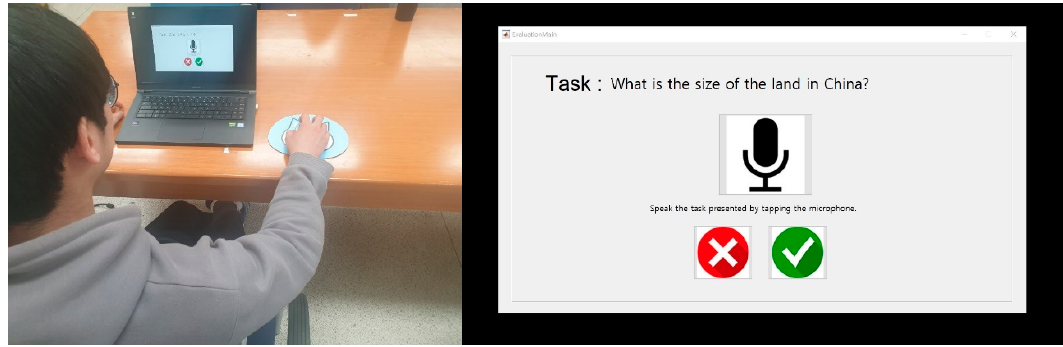
Figure 3. Environment of the experiment.